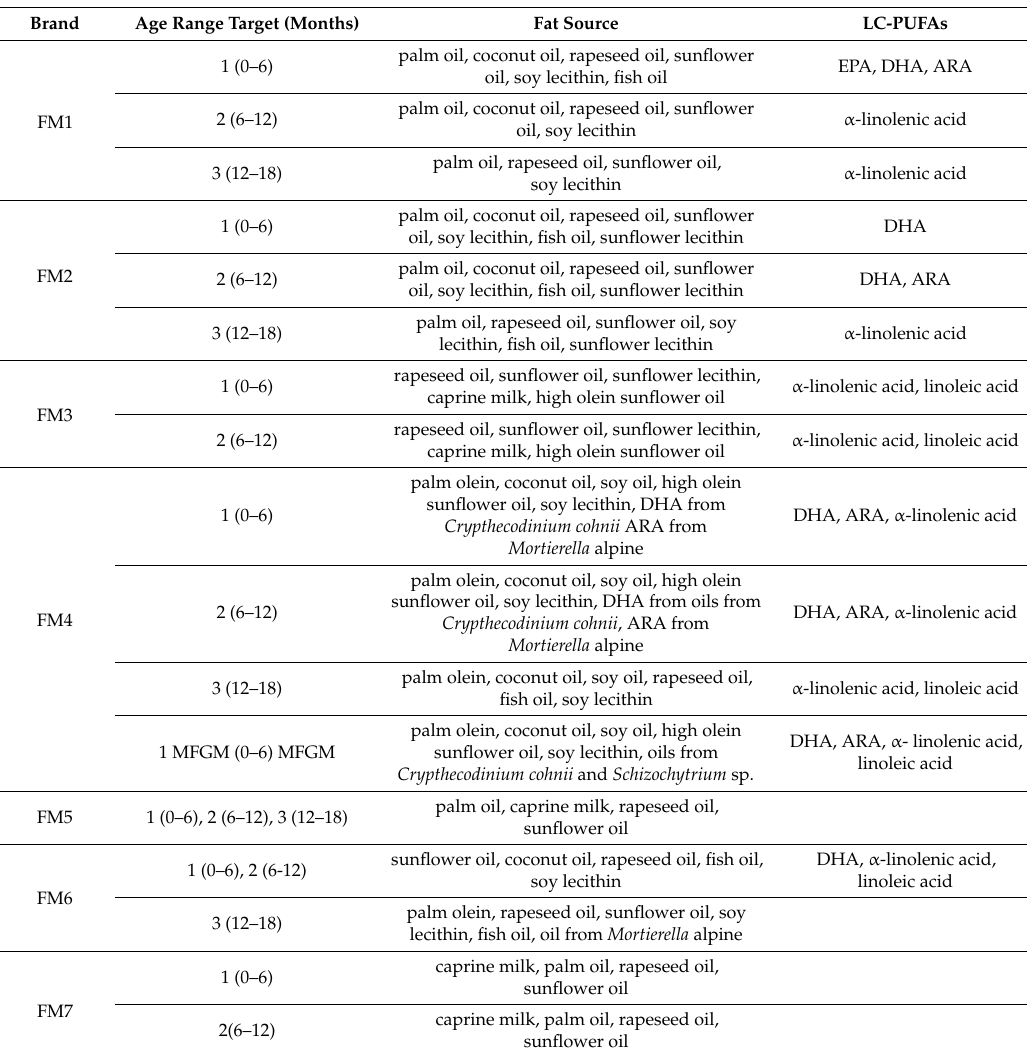
Table 2. Characteristics of milk formula included in the study regarding the fat source and content of LC-PUFAs according to the product